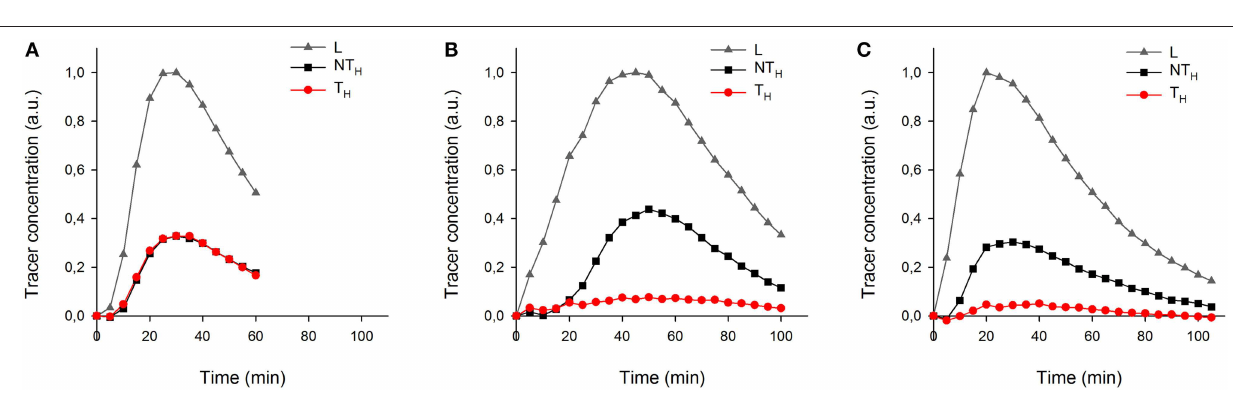
FIGURE 6 | The temporal tracer (decay-corrected activity) profiles of the ROIs L, T H and NT H (as indicated on Figure 4a ) for all conditions: (A) non-treated leaf, (B) half-shade leaf, and (C) half-greased leaf. Tracer was summed per 5min for each